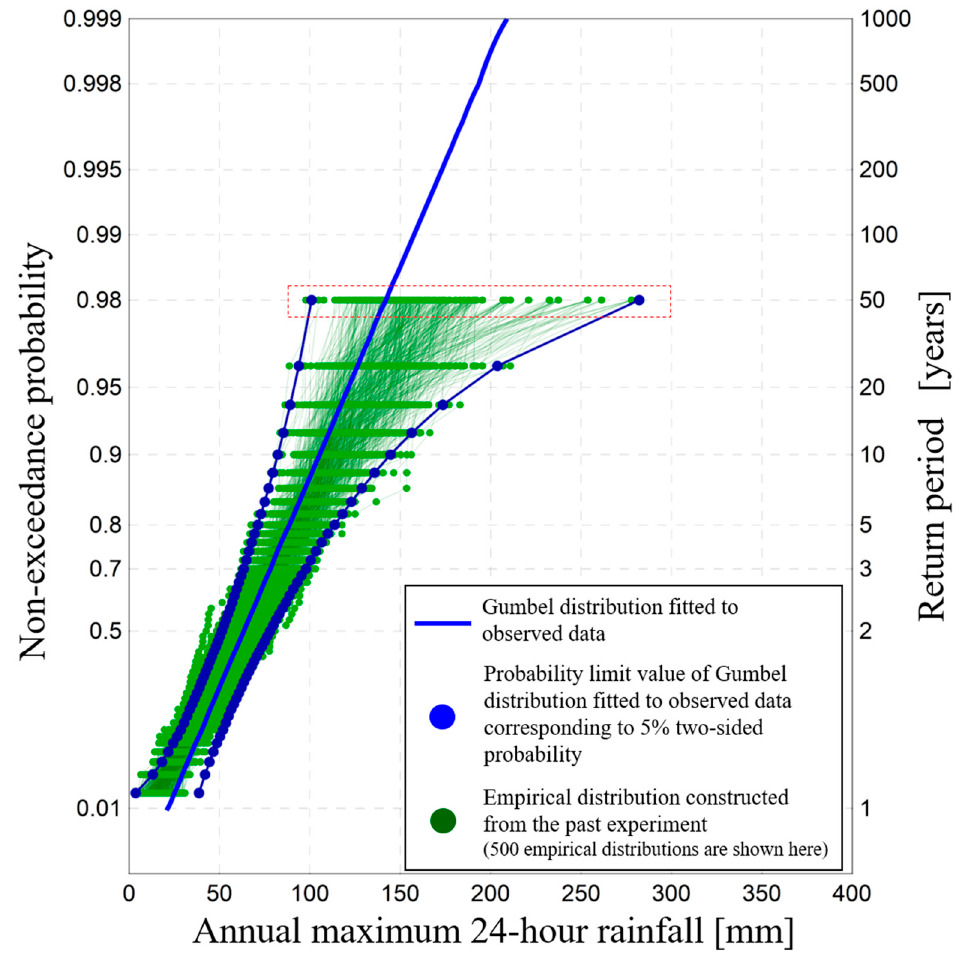
Figure 17. Gumbel distribution fitted to analytical data (observed data), with probability limit values of this Gumbel distribution with 5% two-sided probability and 500 empirical distributions constructed of resampled samples of past experiment data.